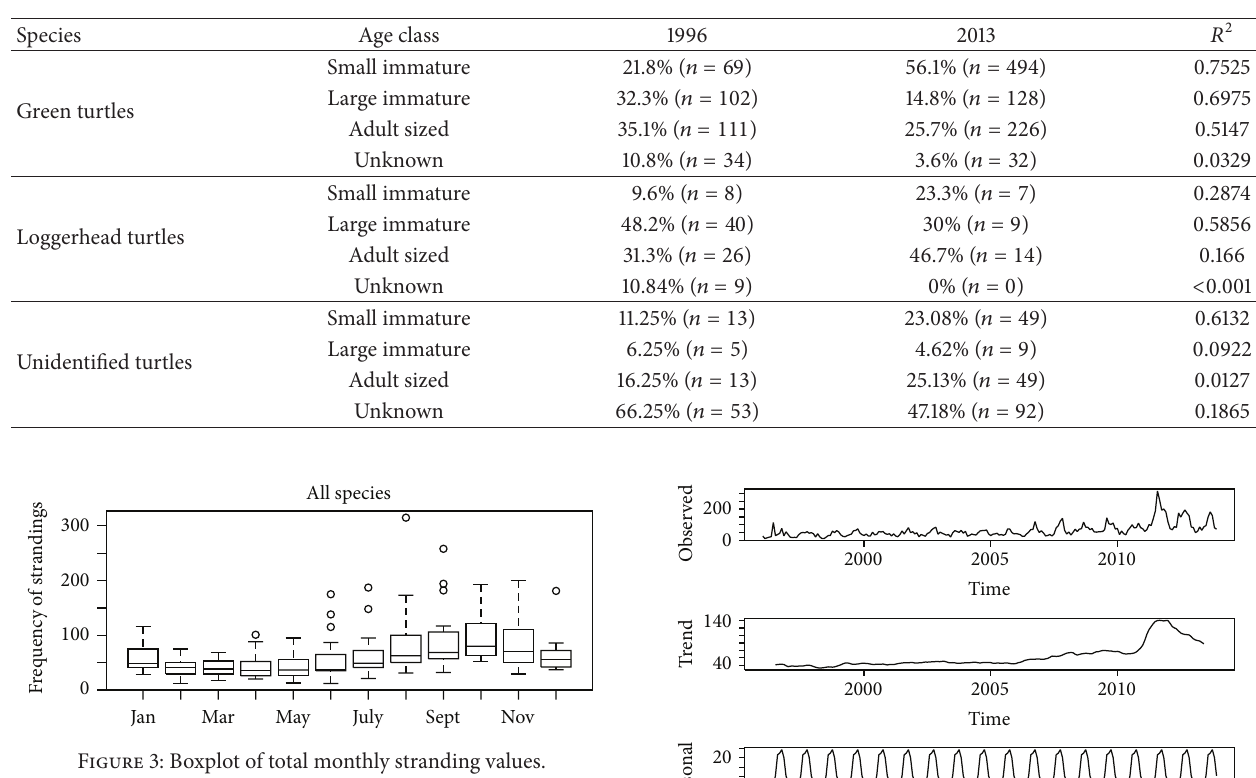
( 𝜒 2 = 17.79 , df = 11, and 𝜌 = 0.0868 ). Loggerhead turtles